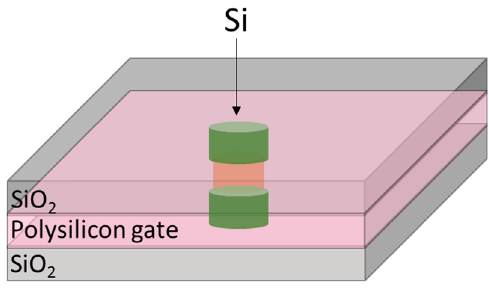
Figure 21. A vertical gate-all-around nanowire structure [111].